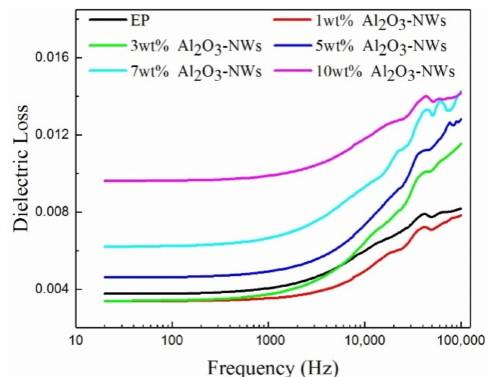
Figure 7. Dielectric loss of Al 2 O 3 -NWs / epoxy resin composites with di ff erent mass ratios as a function of